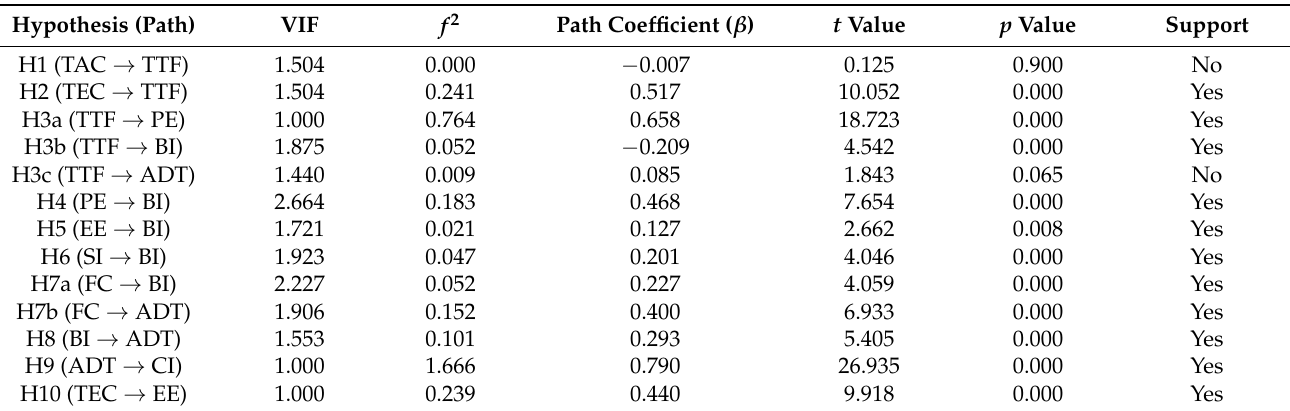
Table 6. Structural model evaluation and hypothesis test